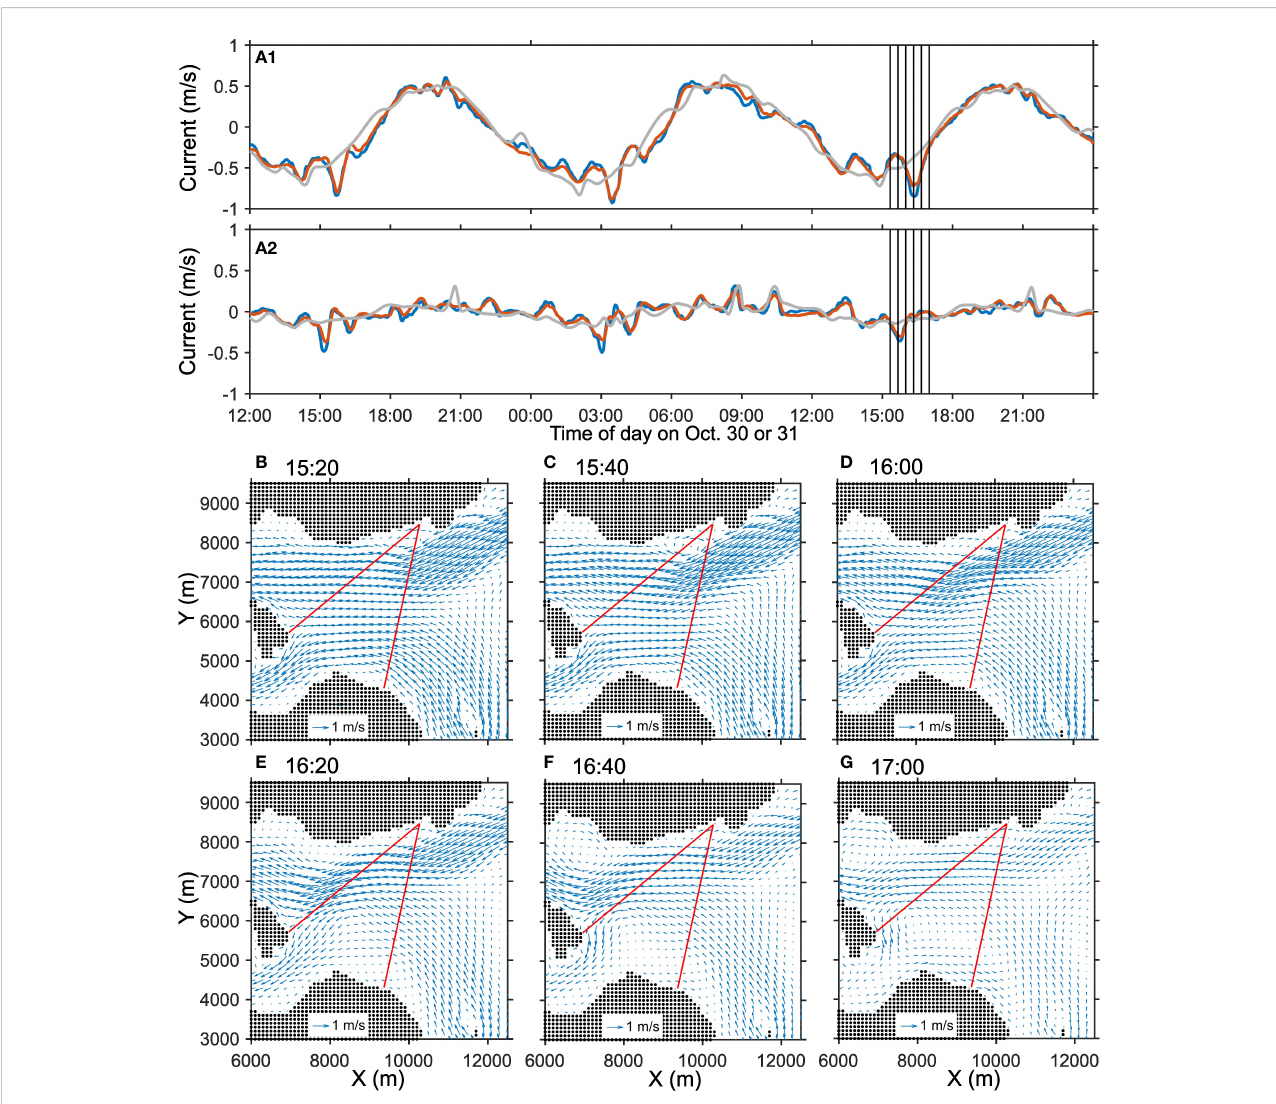
FIGURE 9 (A1, A2) time series of path-averaged current between the S2 and S4 stations and the S3 and S4 stations. The blue, red, and gray lines indicate the reciprocal acoustic transmission results, data assimilation results (case 3 with 98 members), and the model predictions, respectively. The positive value of the path-averaged currents corresponds to the fl ow toward the S4 station for both station pairs. Panels (B-G) show the snapshots of velocity fi elds at times shown as the vertical bars in (A) . The red lines in panels (B-G) are the paths connecting the S2 and S4 stations and the S3 and S4